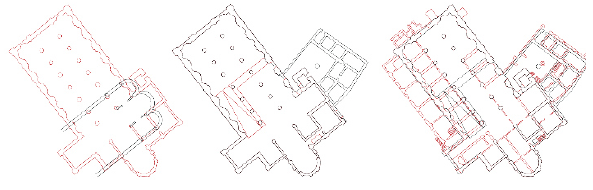
Figure 1. The evolution of the building (in red the new built part for each main step, below).